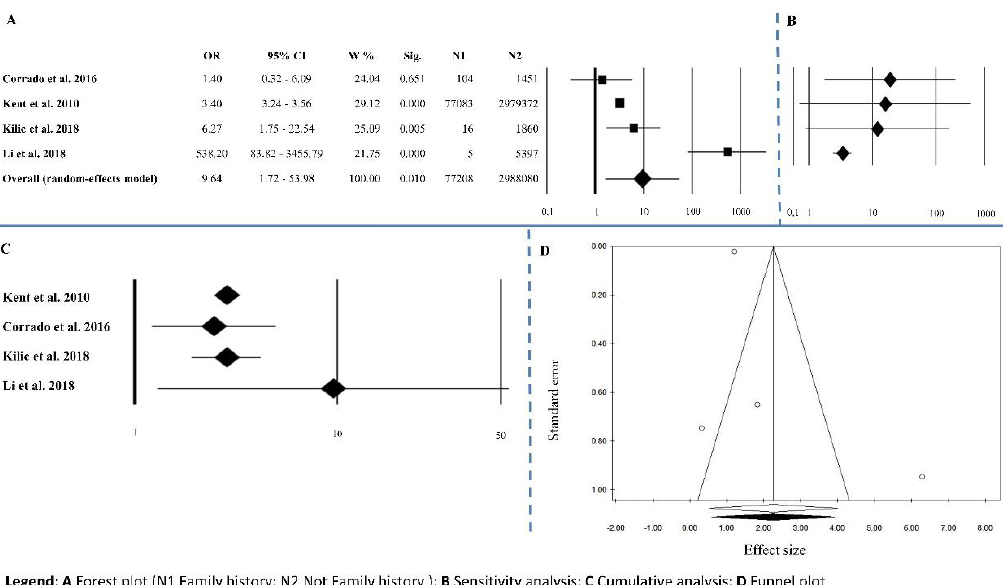
Figure 7. Family history of abdominal aortic aneurysm (AAA). ( A ) Forest plot (N1 Family history; N2 Not Family history); ( B ) sensitivity analysis; ( C ) cumulative analysis; ( D ) funnel plot.